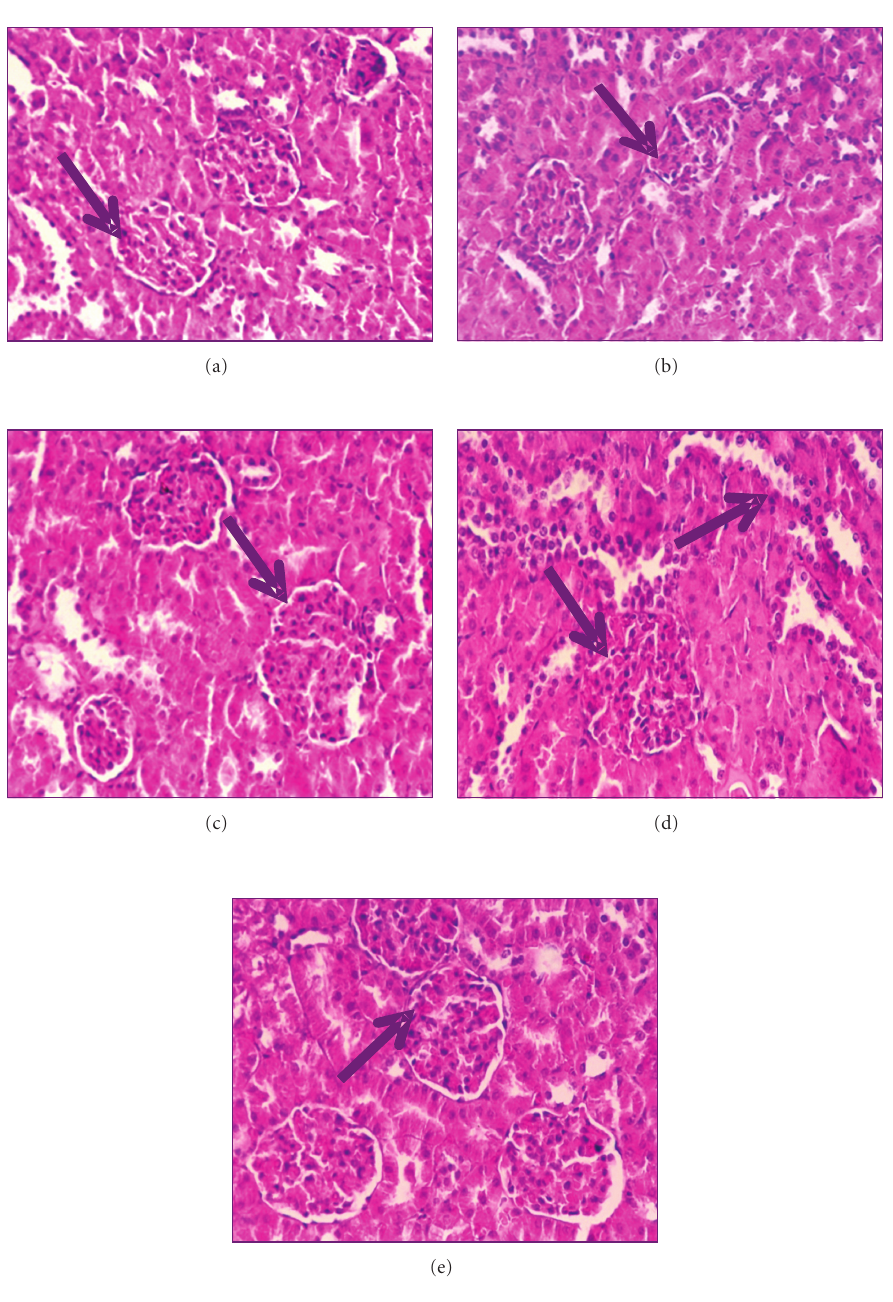
Figure 4: Photomicrography of kidney sections (200x) of control (a), control treated with ethanol extract (b), control treated with chloroform extract (c), control treated with petroleum ether extract (d), and control treated with silymarin (e) stained with haematoxylin and